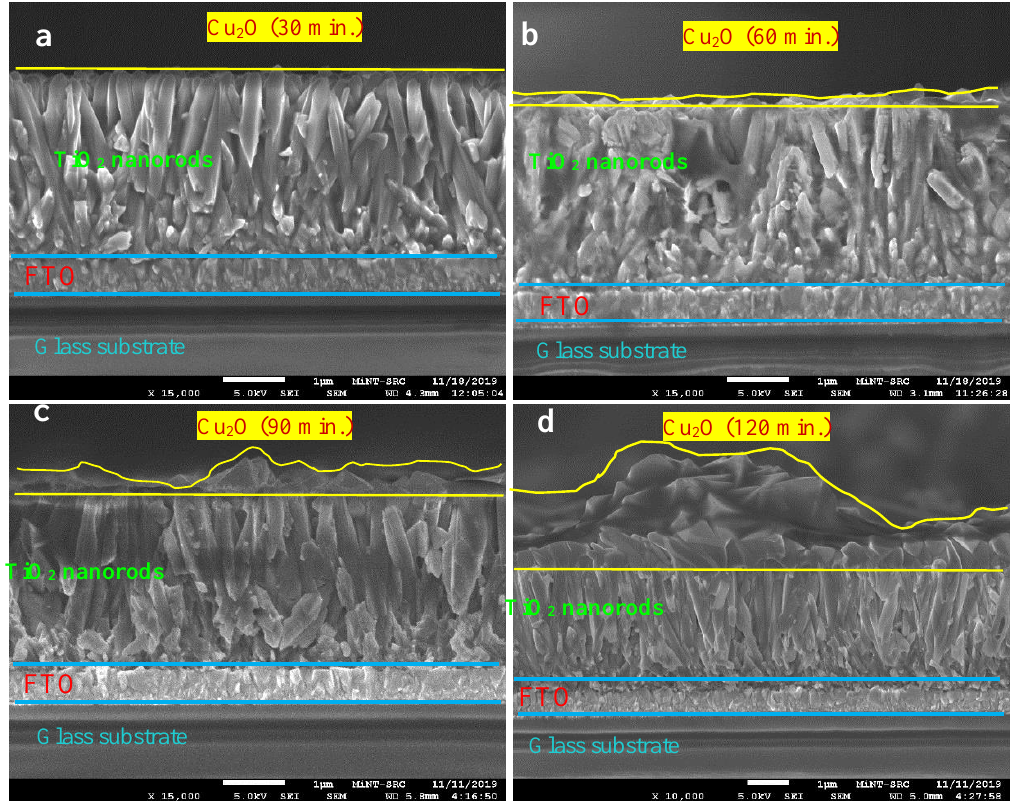
Figure 4. FE-SEM images of the cross-sectional images after Cu 2 O deposited for (a) 30, (b) 60, (c) 90, and (d) 120 minutes onto TiO 2 nanorods layer